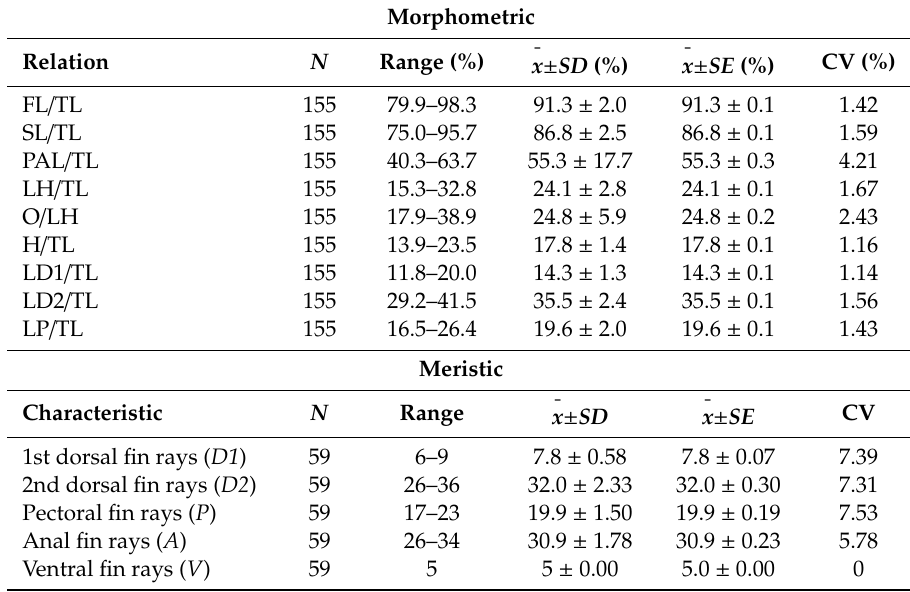
Table1. Morphometric(relativerelationshipsofmeasuredbodyproportions)andmeristiccharacteristics of blue jack mackerel Trachurus picturatus collected during the MEDITS survey in July 2018, eastern Adriatic Sea.